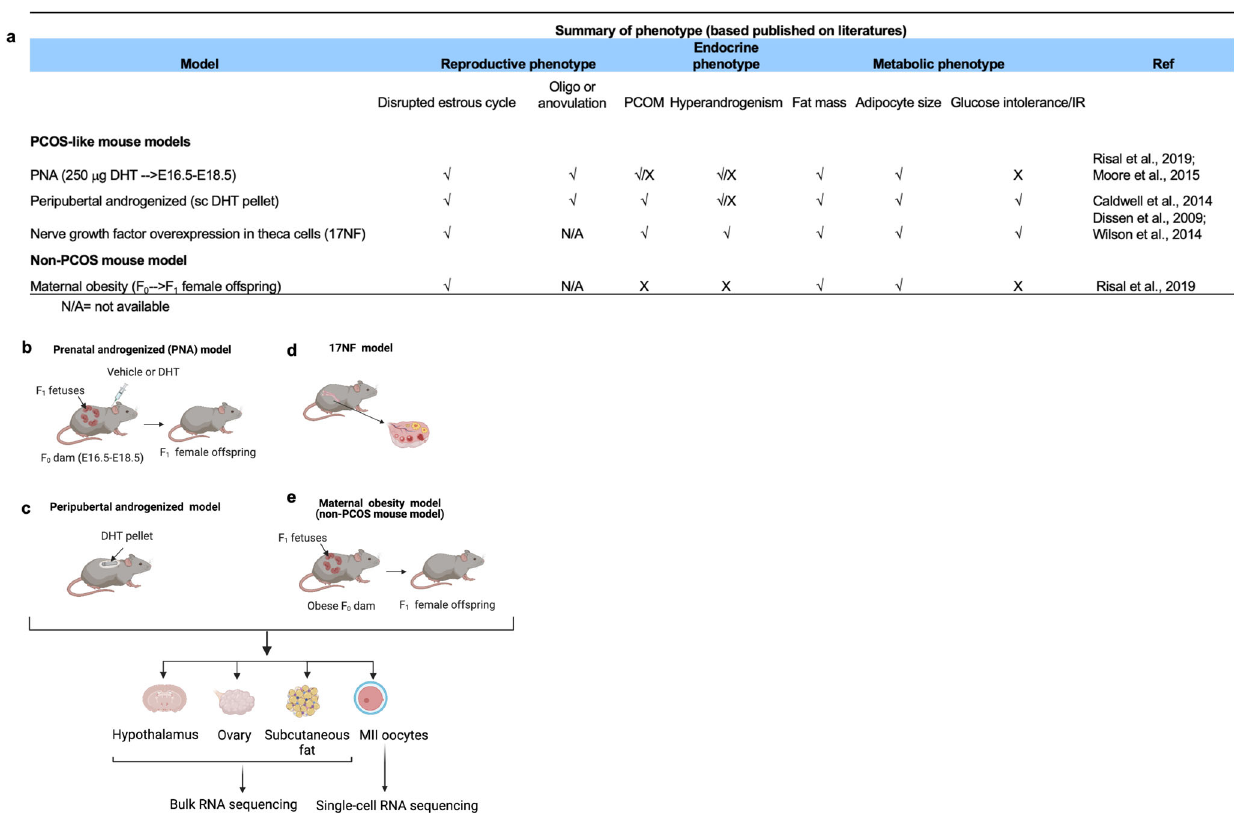
Fig. 1 Summary of metabolic and reproductive phenotype and Illustration of three PCOS-like mouse models and a maternal high-fat high sugar (HFHS)-treated mouse model for comparative transcriptomic analyses of collected target tissues and MII oocytes. a Summary of metabolic and reproductive phenotype of Prenatal androgenized (PNA), Peripubertal androgenized, 17NF, and maternal obesity. b PNA in which F1 female offspring was analyzed. c Peripubertal androgenized (subcutaneous DHT implant), and d 17NF model: theca-cell speci fi c nerve growth factor (NGF) overexpressing transgenic mouse models. e F 1 female offspring of HFHS diet-induced maternal obese model. Different targeted tissues, namely hypothalamus, pituitary, ovaries, and subcutaneous adipose tissue are used for transcriptomic analysis by bulk mRNA sequencing. Metaphase II (MII) oocytes are used for single- cell RNA sequencing. N/A = not